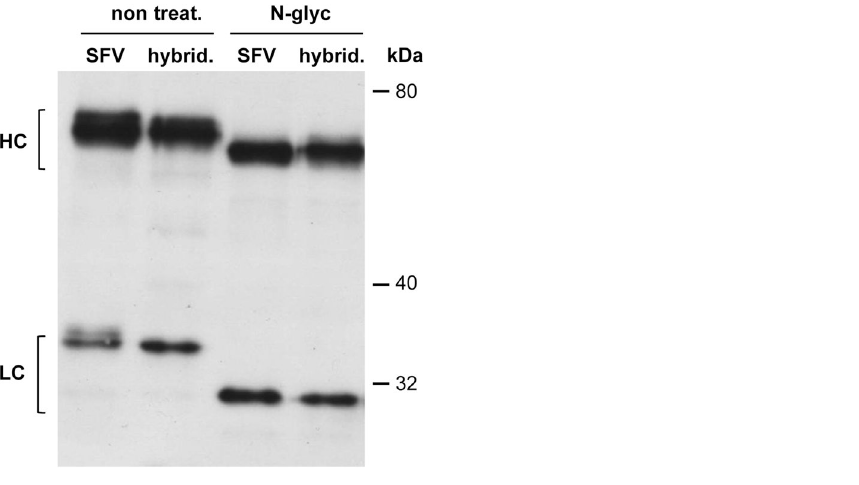
Figure 4. Analysis of glycosylation of A20 mAb. A20 mAb purified from ncSFV-A20-sgPr cell line (SFV) and from A20 hybridoma (hybrid.) were incubated with N-endoglycosidase (N-glyc) and analysed by Western blot under reducing conditions. Non-treated samples were used as control (non treat.).